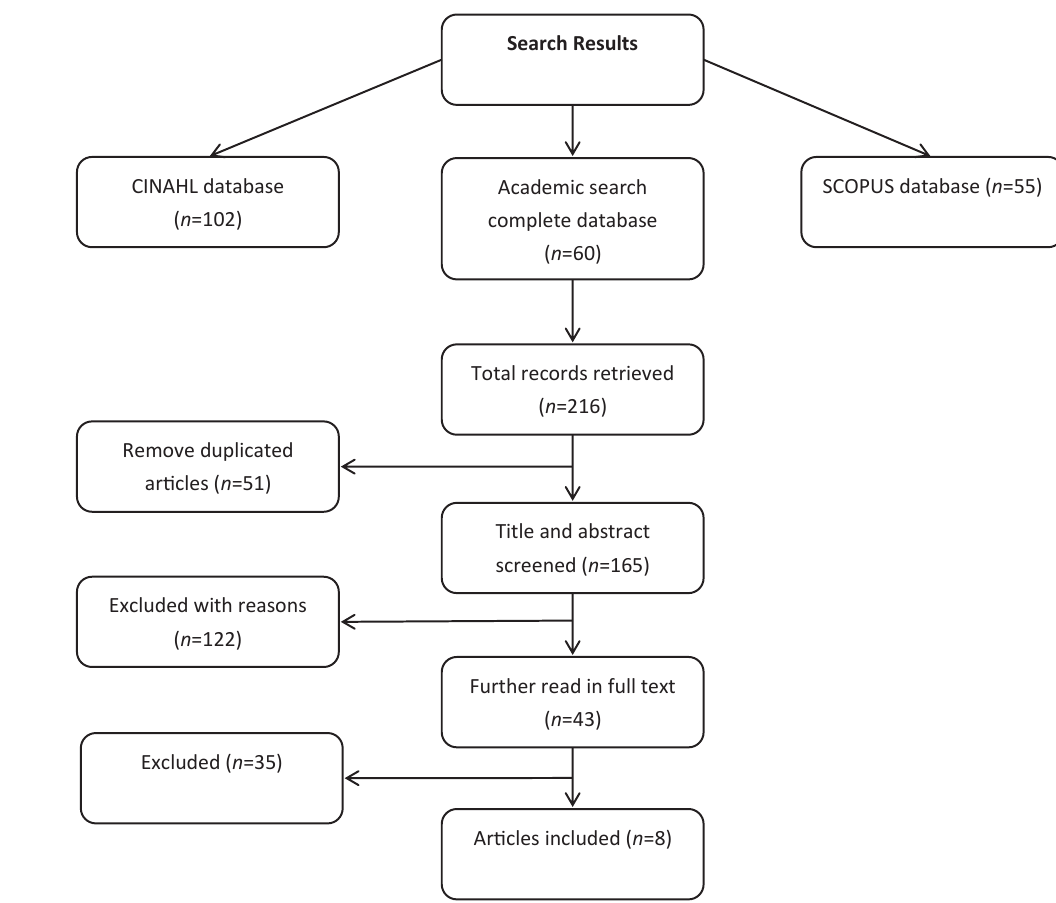
Figure 3. A detailed flow chart of the search